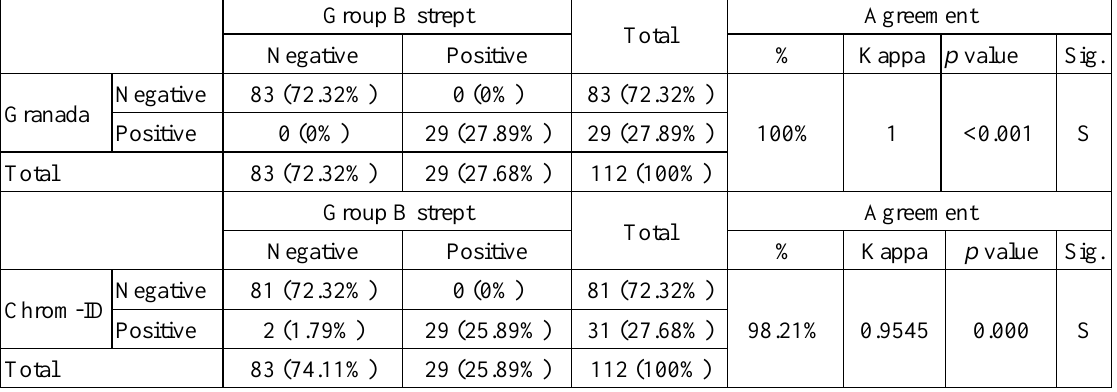
Table 1. Agreement between GBS by reference method versus Granada agar and Chrom ID.